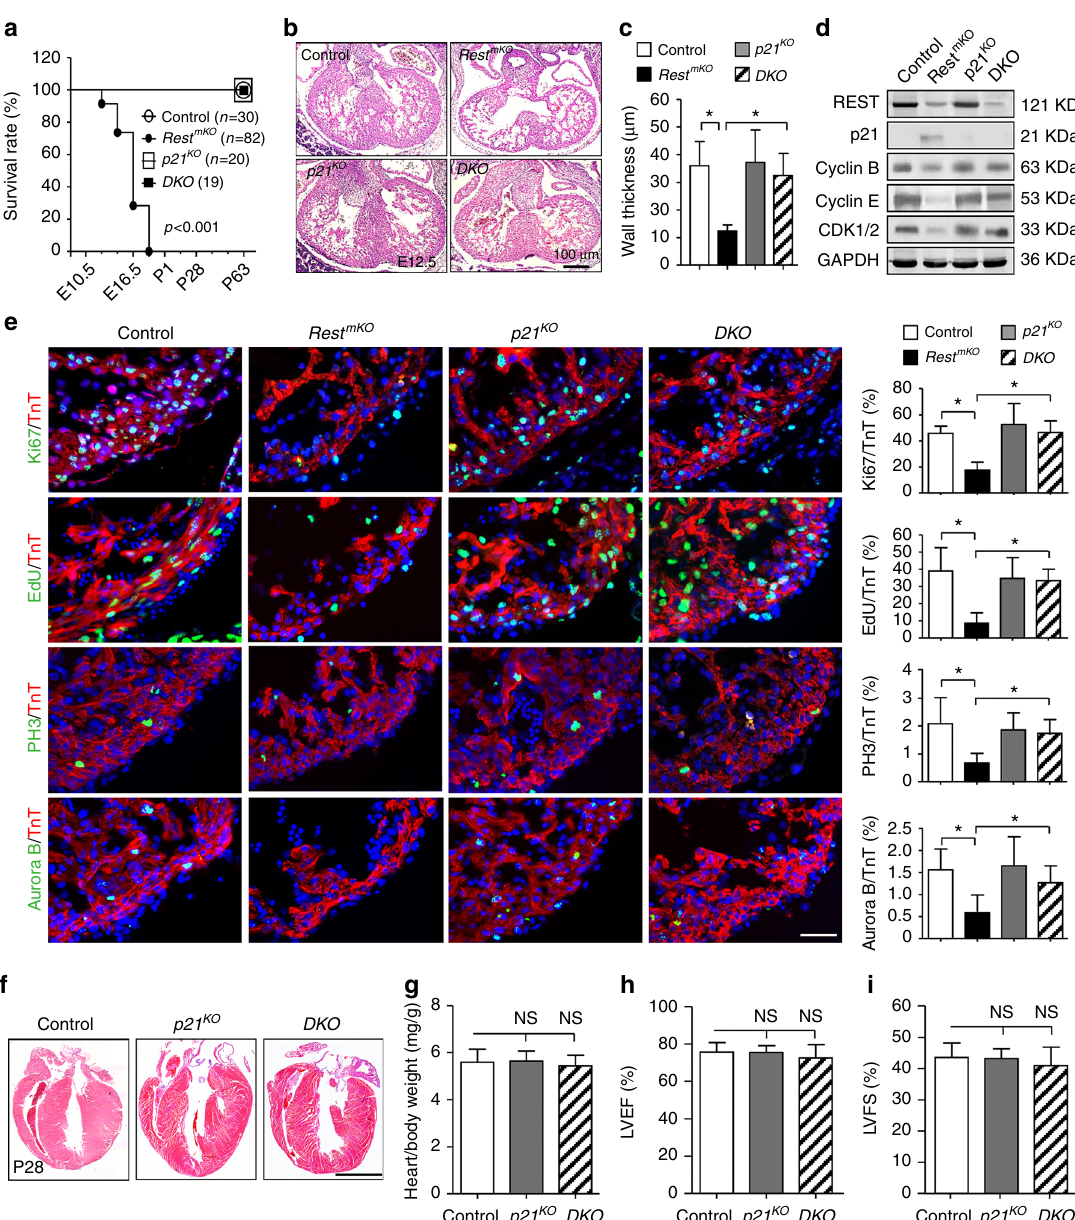
Fig. 4 p21 deletion rescues embryonic heart defects resulting from myocardial Rest deletion. a Survival curve, no difference between control and p21 null ( p21 KO ) or p21/Rest double knockout ( DKO ) group by log-rank (Mantel – Cox) test. p < 0.001 between Rest mKO and each of other groups. b , c H&E-stained E12.5 heart sections showing that thin ventricular walls of Rest deleted hearts are restored by p21 deletion ( n = 3/group). Scale bar = 100 μ m. d Representative western blot revealing that upregulation of p21 and downregulation of Cyclin B, Cyclin E, and CDK1/2 in E12.5 Rest null hearts are restored to the normal levels of control hearts by p21 deletion. e Immunostaining for cell cycle markers indicating that p21 inactivation rescues the cell cycle defect resulting from Rest deletion ( n = 4/group). Scale bar = 40 μ m. f – i H&E staining ( f scale bar = 100 μ m), ratio of heart/body weight ( g ), and echocardiography ( h , i ) showing that P28 Rest / p21 DKO mice have cardiac structure and function comparable to control littermates ( n = 6 – 8/group). Mean ± s.d. * p < 0.05 by one-way ANOVA followed by Tukey ’ s test. NS no signi fi cance